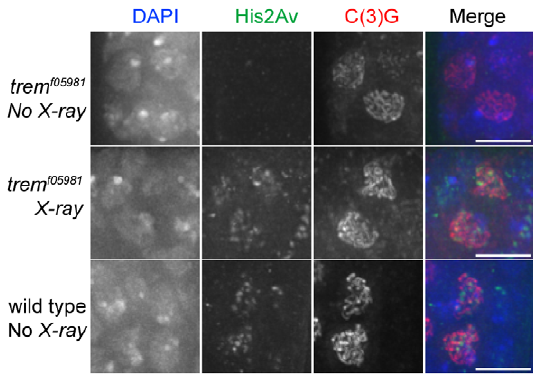
Figure 4. trem f05981 females are able to respond to breaks created by X-ray. Maximum intensity projections of deconvolved Z- series through pro-oocytes in region 2A in trem f05981 females either unexposed or exposed to 1000 Rad of X-ray stained with DAPI and antibodies to c -His2Av and C(3)G and the merge. Unexposed wild-type pro-oocytes in region 2A are shown for comparison of qualitative differences in staining. Two adjacent cells within the cyst show the predicted thread-like pattern of SC. Average number of DSBs in region 2A in trem f05981 females is 0.4, N=57. Average number of DSBs in trem f05981 females 5 hours after exposure to X-ray is 11.3, N=13. Average number of DSBs in wild-type females is 12.5, N=20 (see Table 4). Scale bar, 5 m m.